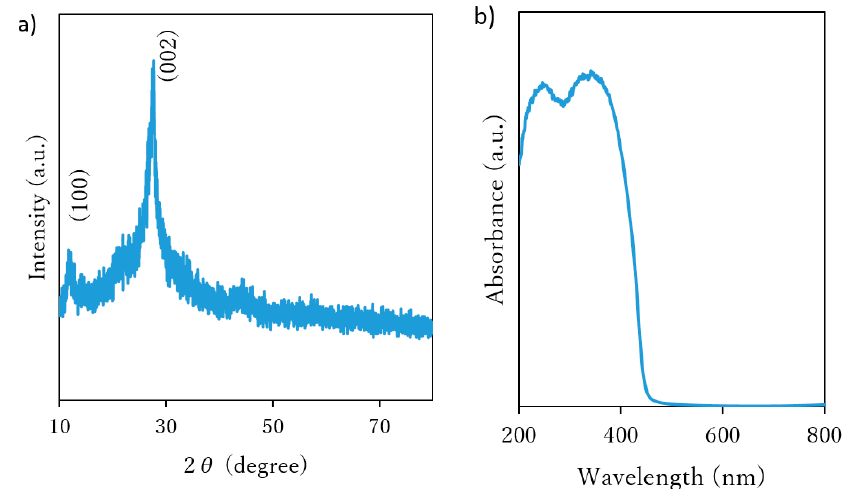
Figure 1. Characterization of powdered C 3 N 4 . ( a ) Pattern of XRD; ( b ) pattern of DRS (diffuse reflectance spectrum).